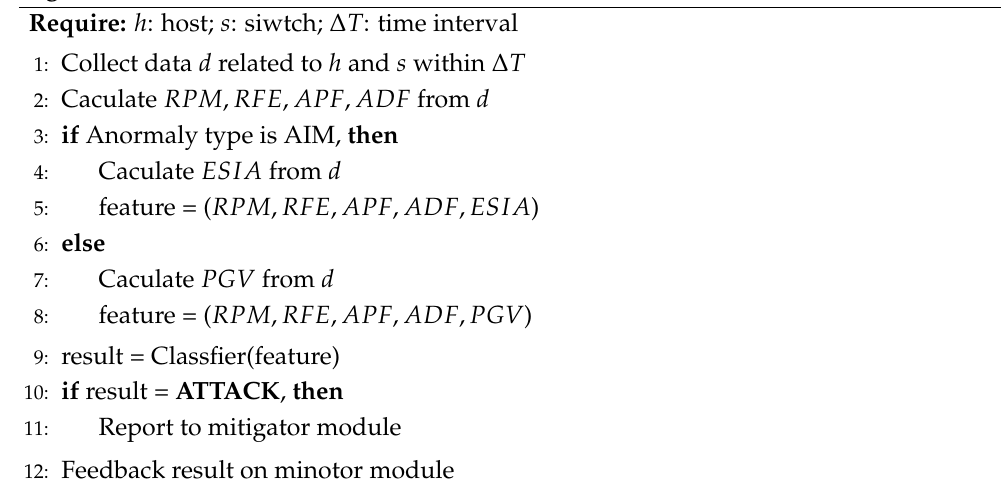
Algorithm 3 Mechanism of Attack